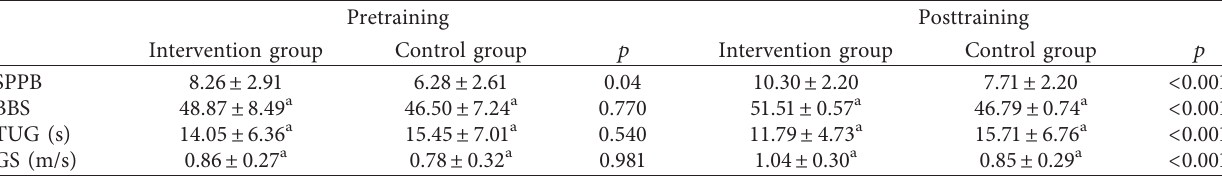
Table 3: Comparison of the variables before and after intervention for the intervention group and the control group.